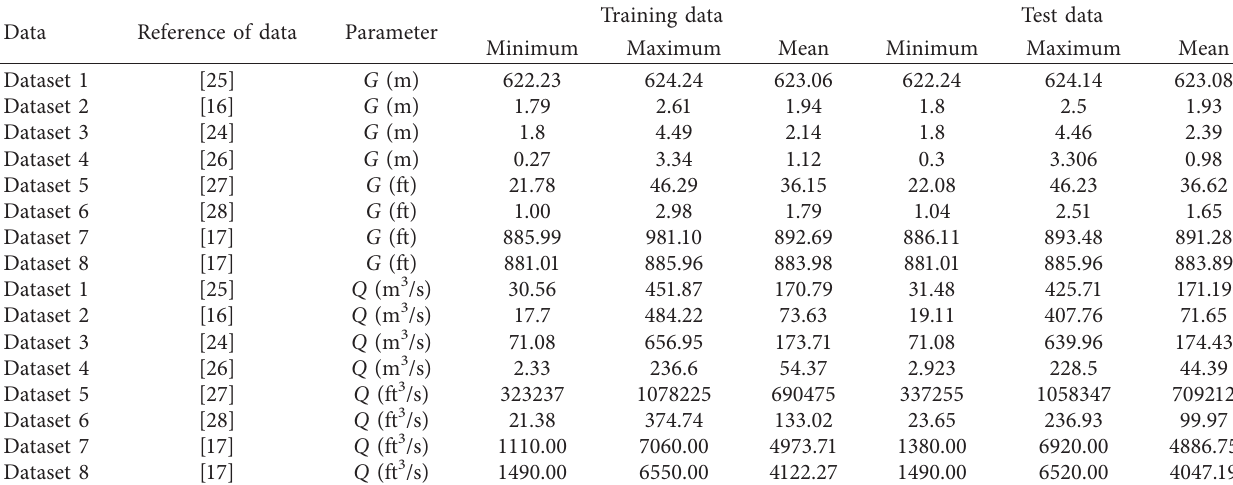
Table 1: Range of calibration and validation